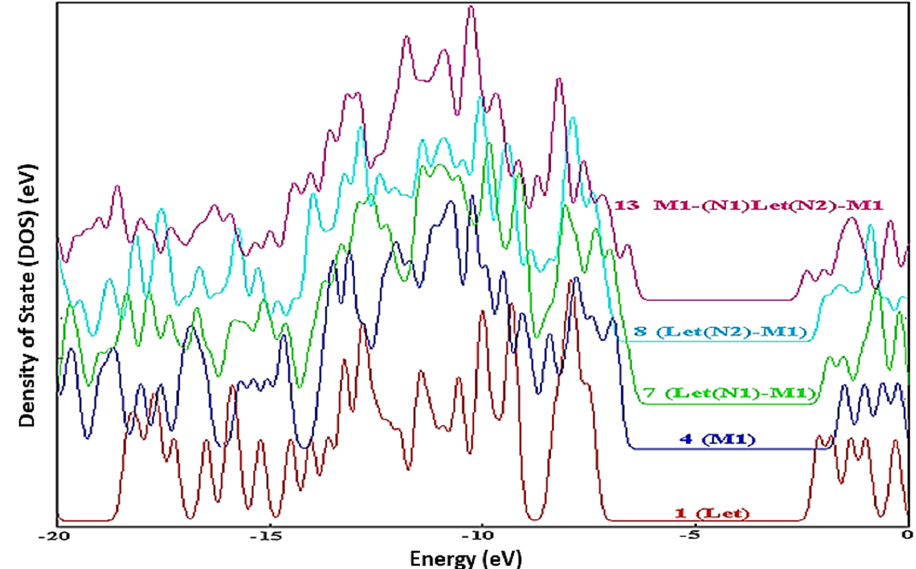
Figure 6. The density of states (DOS) spectra of the drug 1 and copolymer 4 in compounds 7 , 8 , and 13 . Reproduced with permission from ref. [9]; Copyright 2016, World Scientific Publishing Co Pte Ltd.